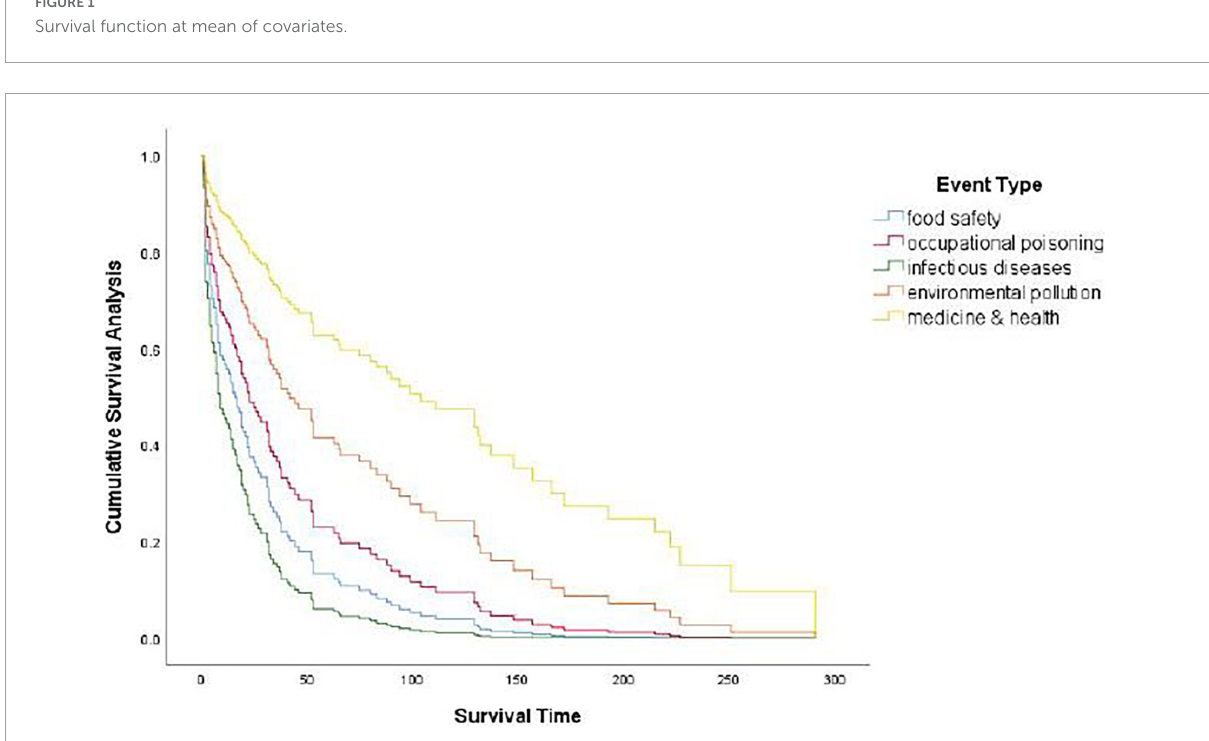
FIGURE2 Survival function of event